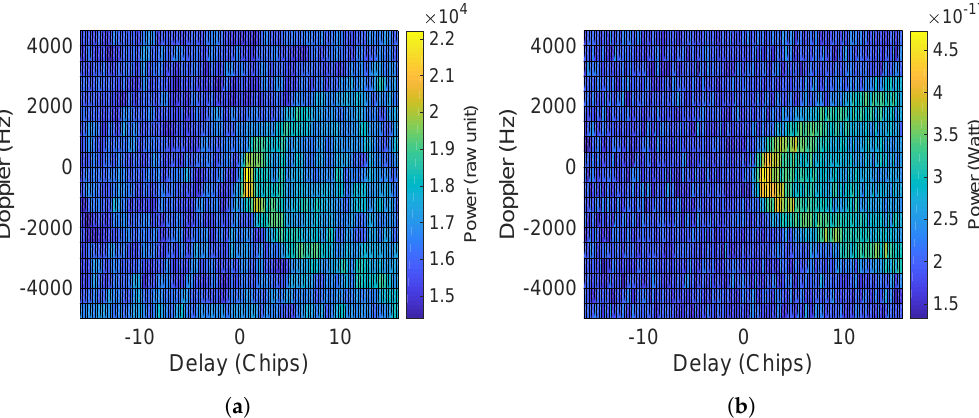
Figure 4. A measured DDM onboard TDS-1 ( a ) and the modeled DDM after adding an artificial Gaussian noise ( b ) at a wind speed of 14.74 m/s. Specular point position: Latitude 34.38 Longitude 16.25 degrees. Time: 3 November 2015, 13:59.47. The SGR-ReSI receiver is operated in unmonitored automatic gain control mode (AGM) so that the gain of the intermediate-frequency voltage amplifier of the global navigation satellite system (GNSS) receiver is adaptively adjusted by the automatic gain control according to the received power level [24]. The variable gain level is not recorded and